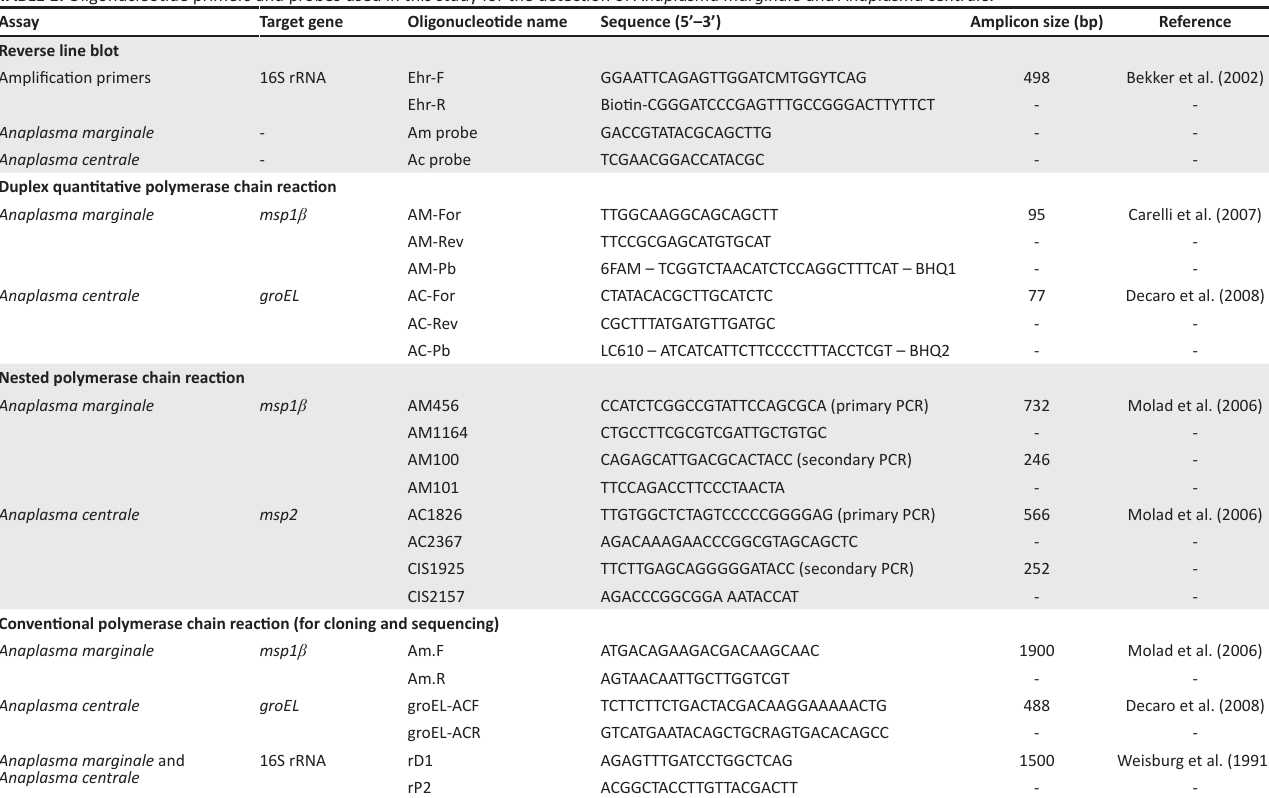
TABLE 1: Oligonucleotide primers and probes used in this study for the detection of Anaplasma marginale and Anaplasma centrale.